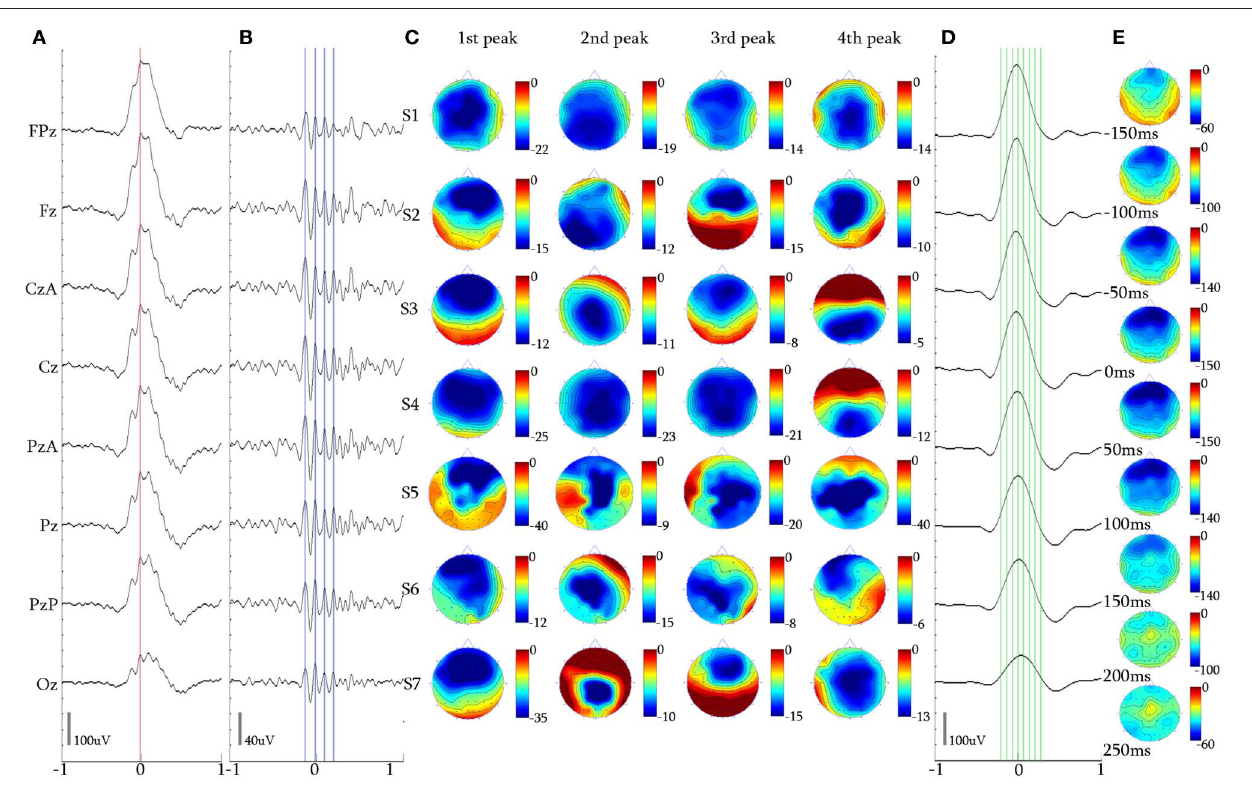
(D) 4Hz low-pass filtered waveform of the averaged KC signal. (E) Topographic analysis in 2D electrode space of the averaged slow KC wave, representing the KCs that contained 4-peak iKCo (cursors and axis as in Figure 4 ).